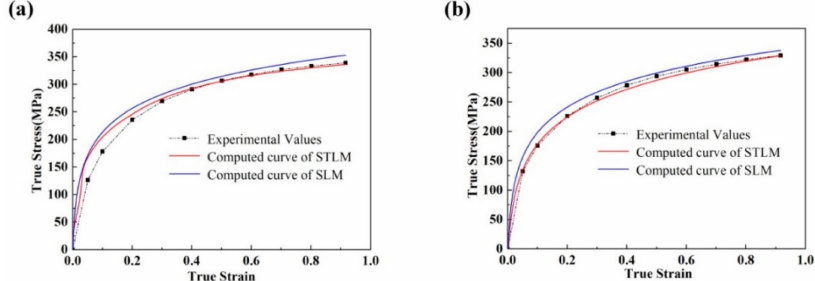
Figure 10. Comparison of stress–strain curves calculated by two models with actual stress–strain curves: ( a ) when the grain size is 30 µ m, Ø1 mm × 1.5 mm; ( b ) when the grain size is 50 µ m, Ø1 mm × 1.5